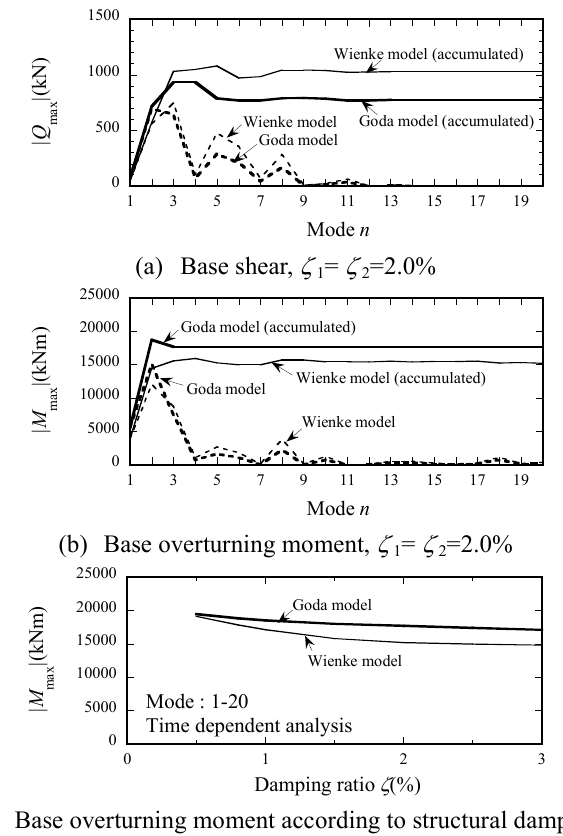
Fig. 5 The maximum section forces by time dependent analysis ( λη